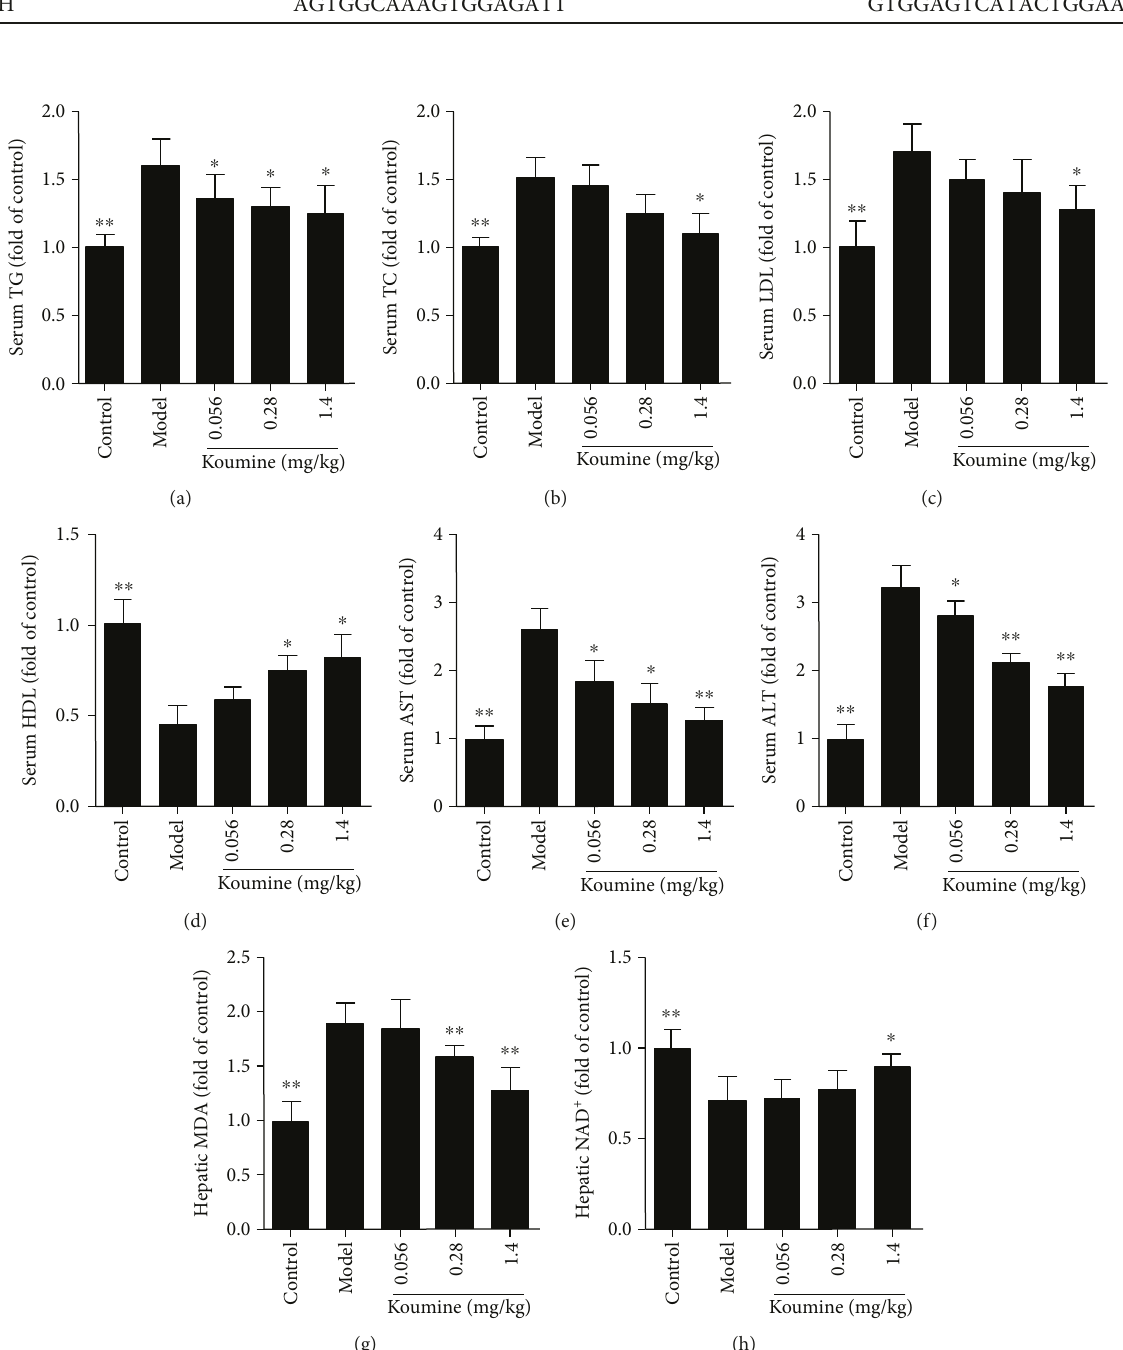
Figure 2: E ff ect of koumine on serological indexes of NAFLD rats induced by fat diet. TG: total cholesterol; TG: triglyceride; HDL: high-density lipoprotein; LDL: low-density lipoprotein; AST: aspartate aminotransferase; ALT: alanine aminotransferase; hepatic malondialdehyde (MDA) and nicotinamide adenine dinucleotide (NAD). ∗ p < 0 05 and ∗∗ p < 0 01 , compared with the model